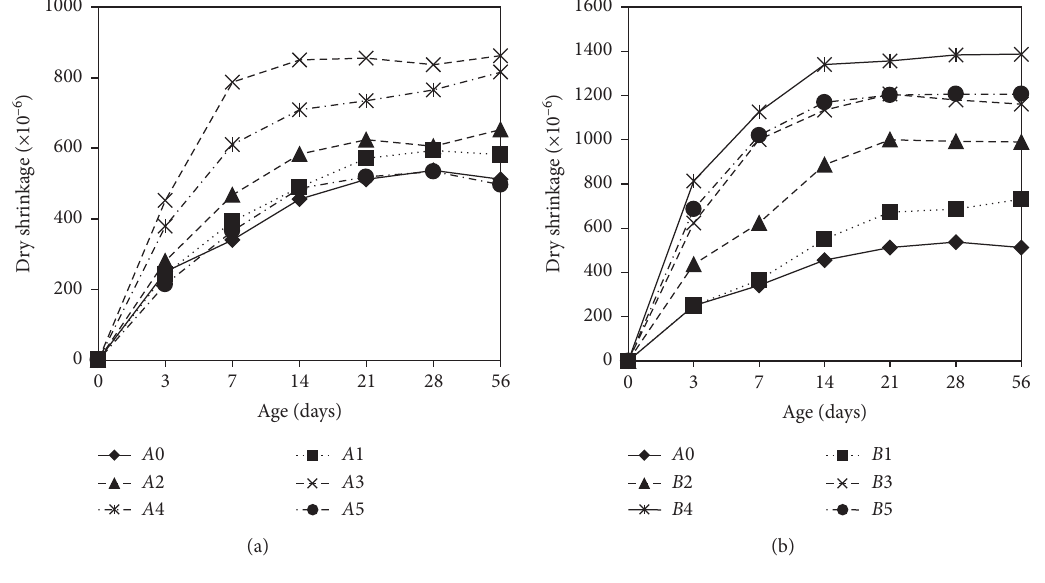
Figure 5: FC dry